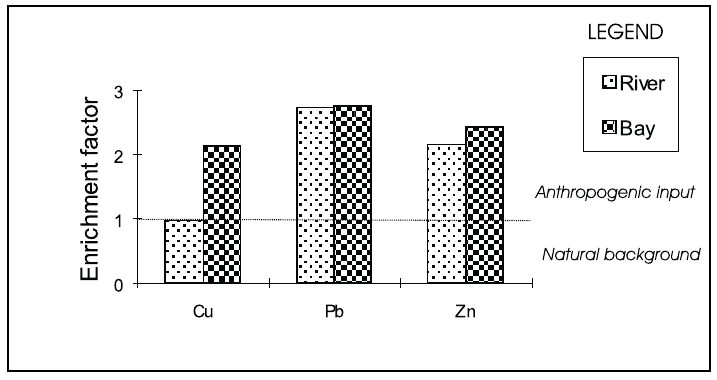
Fig. 9 – Comparison of average enrichment factors of fluvial and Guanabara Bay